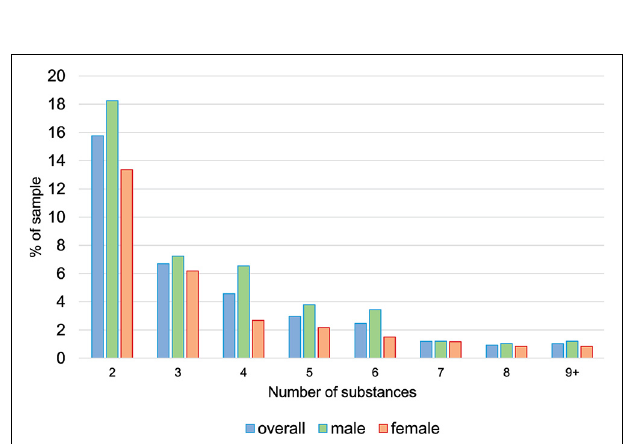
FIGURE 2 | Prevalence of counts of substances (based on extended questionnaire and excluding alcohol and tobacco) used during the previous year at age 20. Note . Categories nine and higher were combined due to low prevalence.